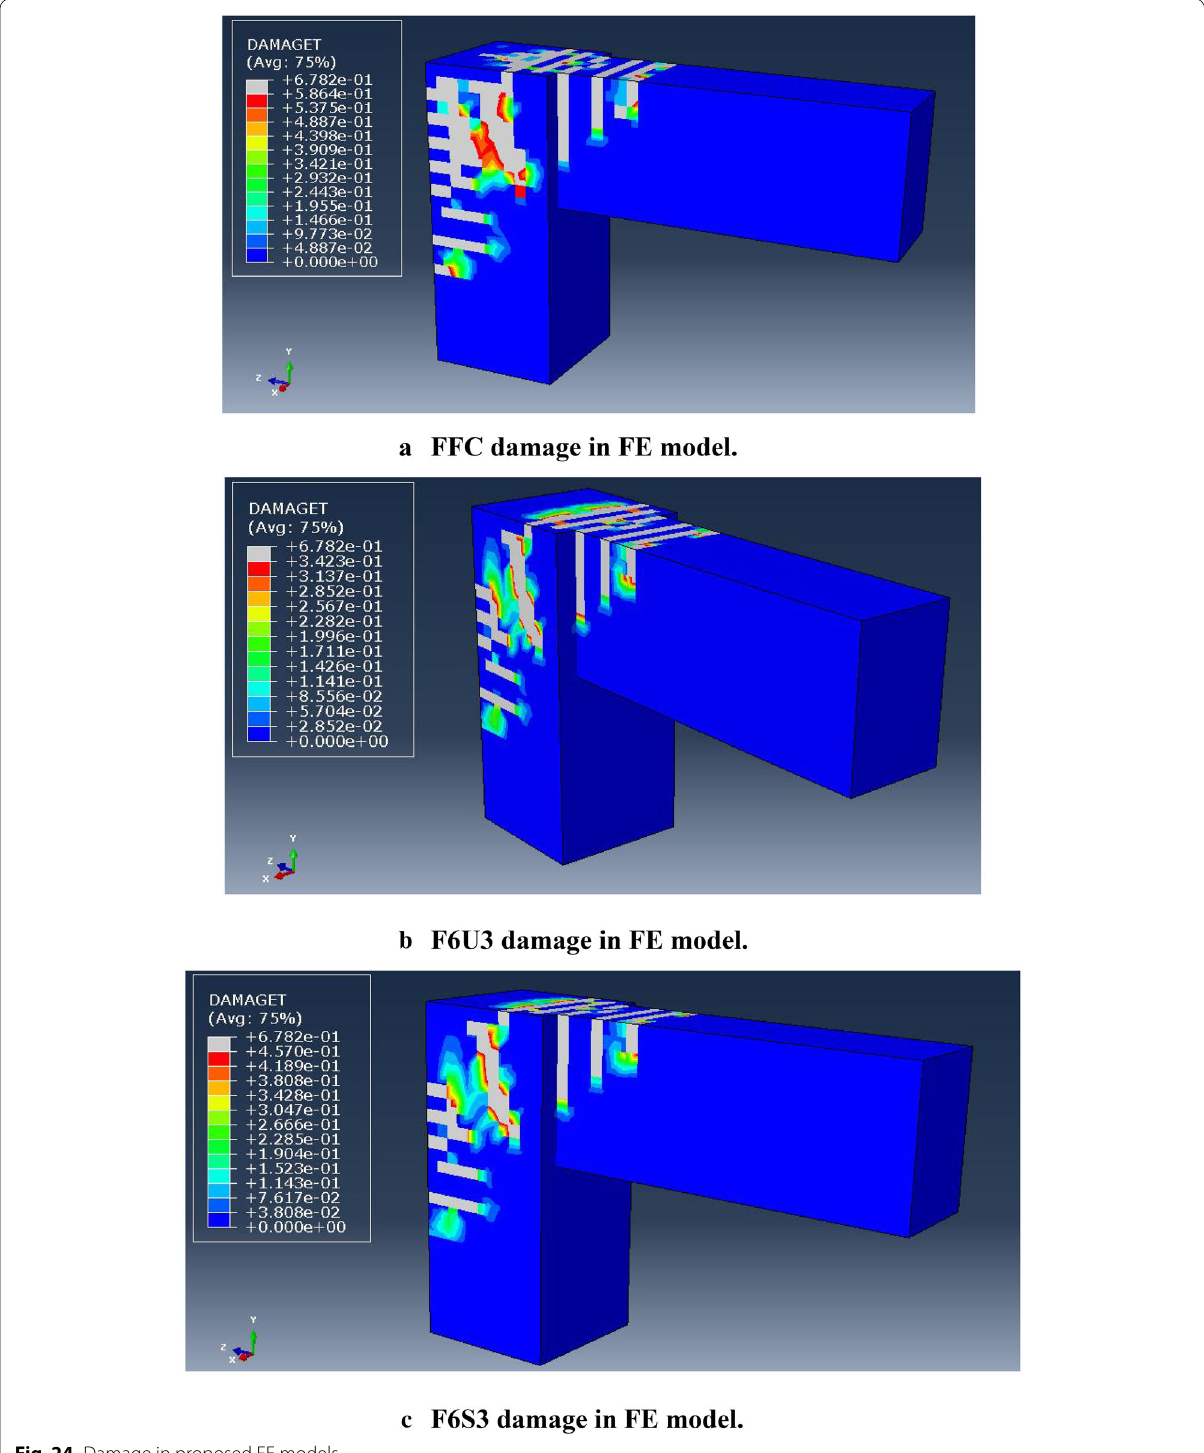
Fig. 24 Damage in proposed FE